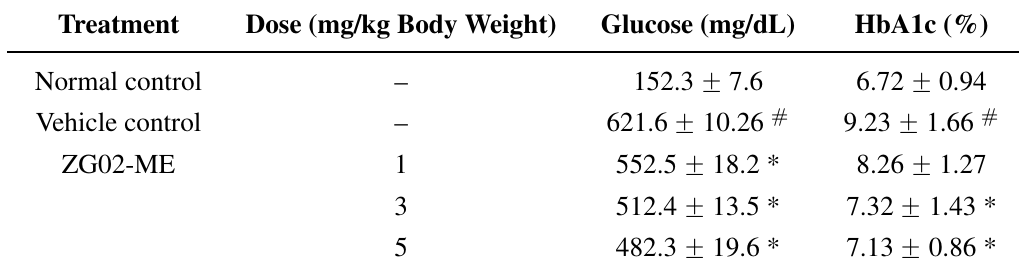
Table 2. Effect of ZG02-ME on blood glucose and HbAlc levels in diabetic-obese ( db / db )